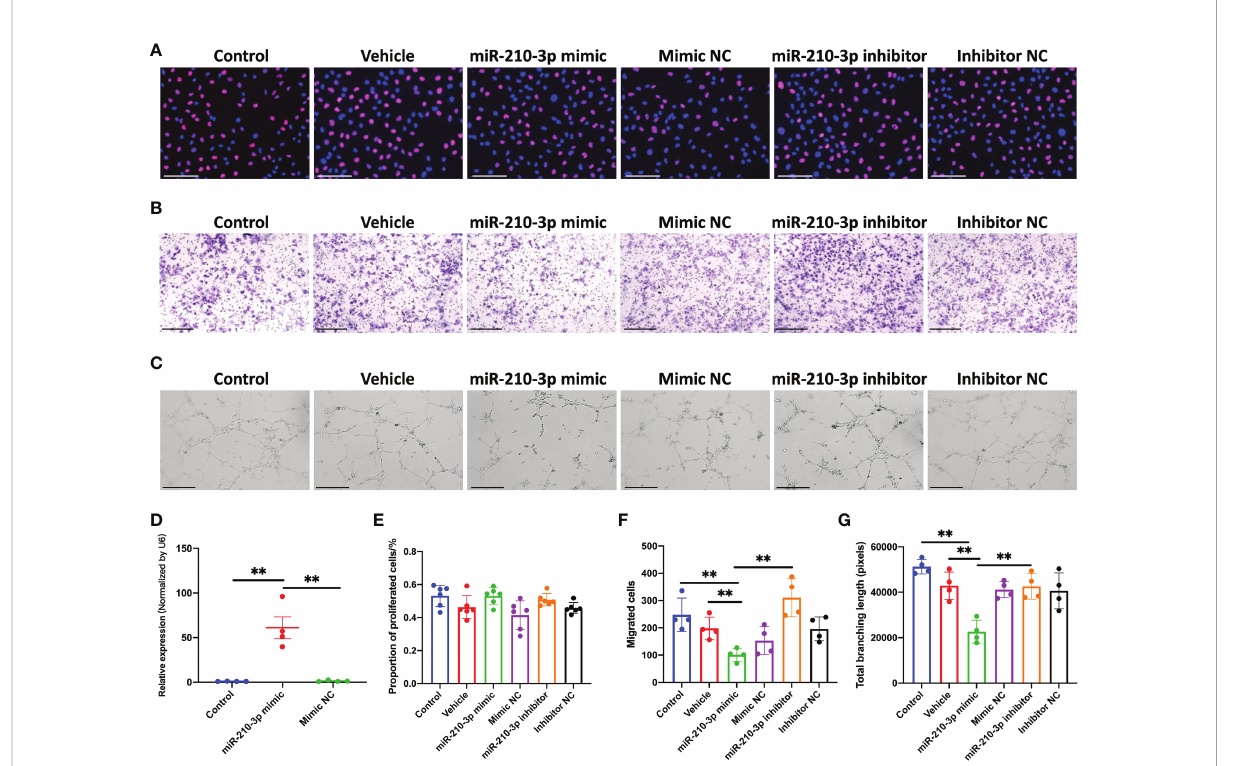
FIGURE 2 miR-210-3p affects the angiogenic ability of HUVECs in vitro under hypoxia. (A) EdU staining for control HUVECs and HUVECs transfected with vehicle, miR-210-3p mimic, mimic NC, miR-210-3p inhibitor or inhibitor NC and cultured under hypoxia (1% O 2 ). Scale bars: 150 m m. (B) Transwell assay of control HUVECs and HUVECs transfected with vehicle, miR-210-3p mimic, mimic NC, miR-210-3p inhibitor or inhibitor NC and cultured under hypoxia (1% O 2 ); Scale bars: 300 m m. (C) Representative images of tube formation by control HUVECs and HUVECs transfected with vehicle, miR-210-3p mimic, mimic NC, miR-210-3p inhibitor or inhibitor NC. Scale bars: 275 m m. (D) Quanti fi cation of miR- 210-3p expression levels in control HUVECs and HUVECs transfected with miR-210-3p mimic or mimic NC using RT – qPCR. (E) Quanti fi cation of proportion of proliferated cells. (F) Quanti fi cation of the number of migrated cells. (G) Quanti fi cation of the total branching length of each group. ** P < 0.01. NC, negative control. All data are presented as the means ± standard deviations. Statistical signi fi cance was determined using unpaired, 2-tailed Student ’ s t